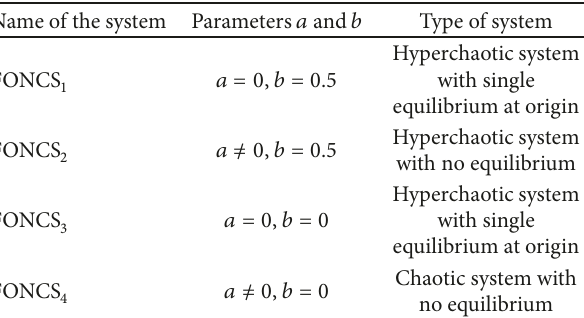
Table 4: Choice of parameters and type of the system. Name of the system Parameters 𝑎 and 𝑏 Type of system FONCS